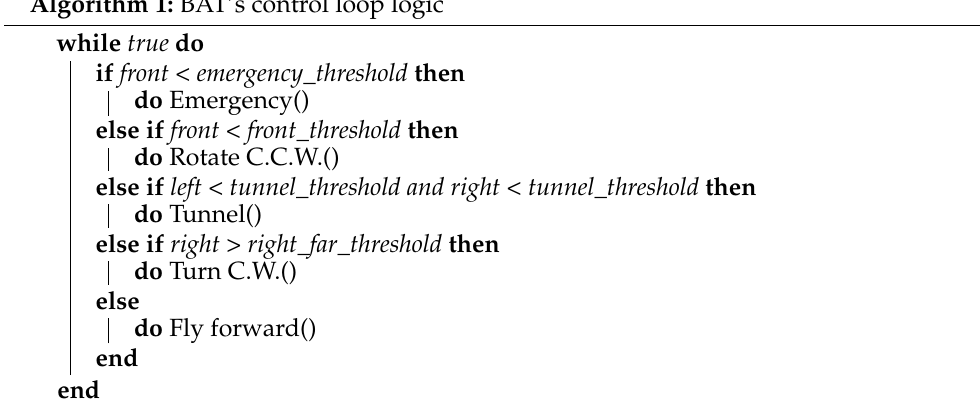
Algorithm 1: BAT’s control loop